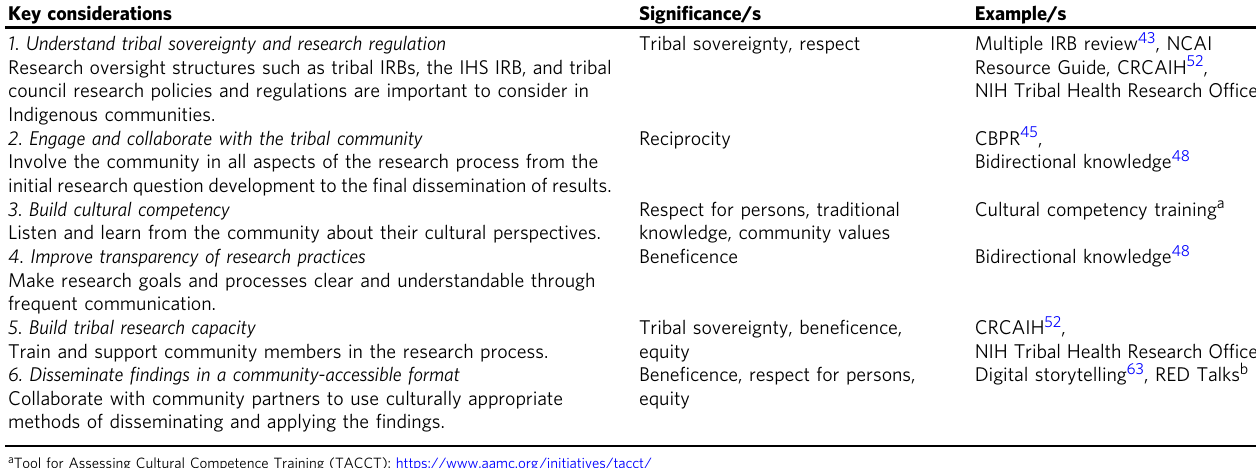
Table 1 Principles for engaging in ethical research with Indigenous